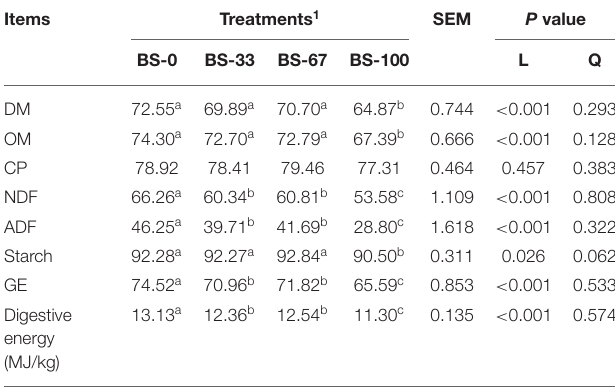
TABLE 4 | Effects of dietary barley starch proportions on nutrient apparent digestibility of fattening Hu sheep ( n = 6/group,